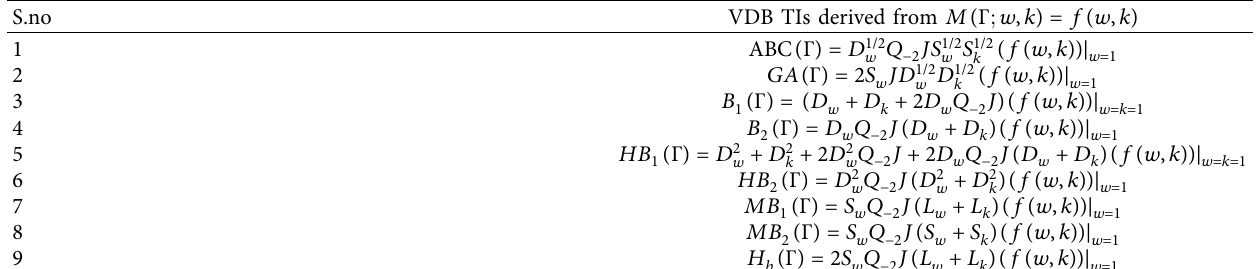
Table 2: VDB TIs derived from